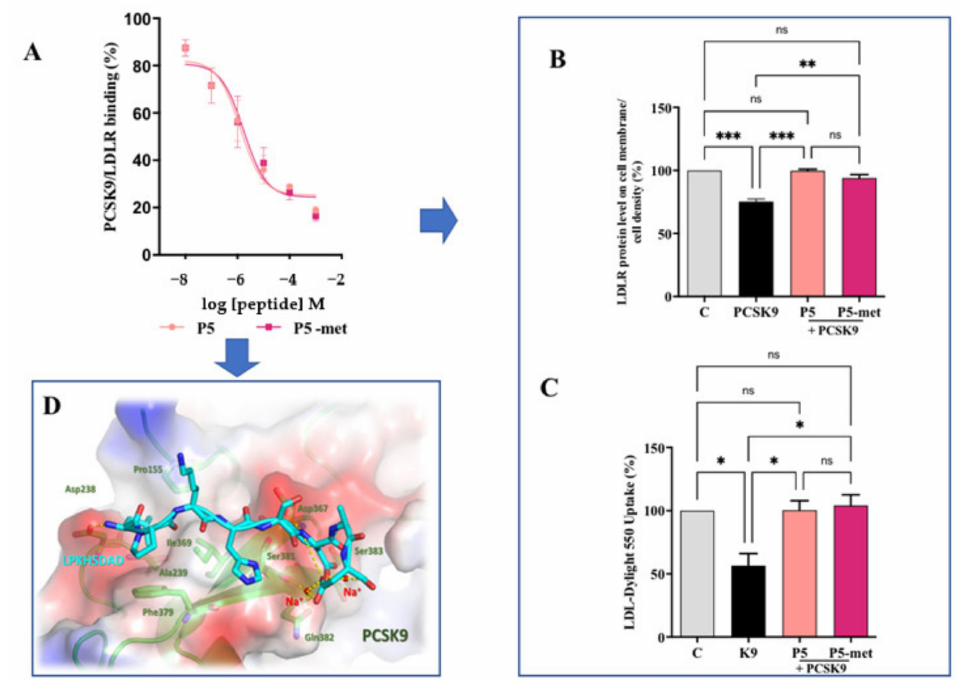
Figure 6. Inhibition of the PPI between PCSK9 and LDLR. ( A ) Impairment of the protein–protein interaction between PCSK9 and LDLR. ( B ) The treatment of HepG2 cells with PCSK9 (4 µ g/mL) reduced active LDLR protein levels localized on the surface of cells, which were restored by P5 or P5-met (50 µ M). ( C ) The decreased functional ability of HepG2 cells to absorb LDL from the extracellular space observed after incubation with PCSK9 (4 µ g/mL) is improved after treatment with both peptides. ( D ) Hypothetical binding mode of P5-met in the LDLR binding site located on the surface of PCSK9. The data points represent the averages ± SD of four independent experiments performed in duplicate. Data were analyzed by One-Way ANOVA followed by Tukey’s post-hoc test; (*) p < 0.05, (**) p < 0.01, and (***) p < 0.0001. C: control sample; ns: not